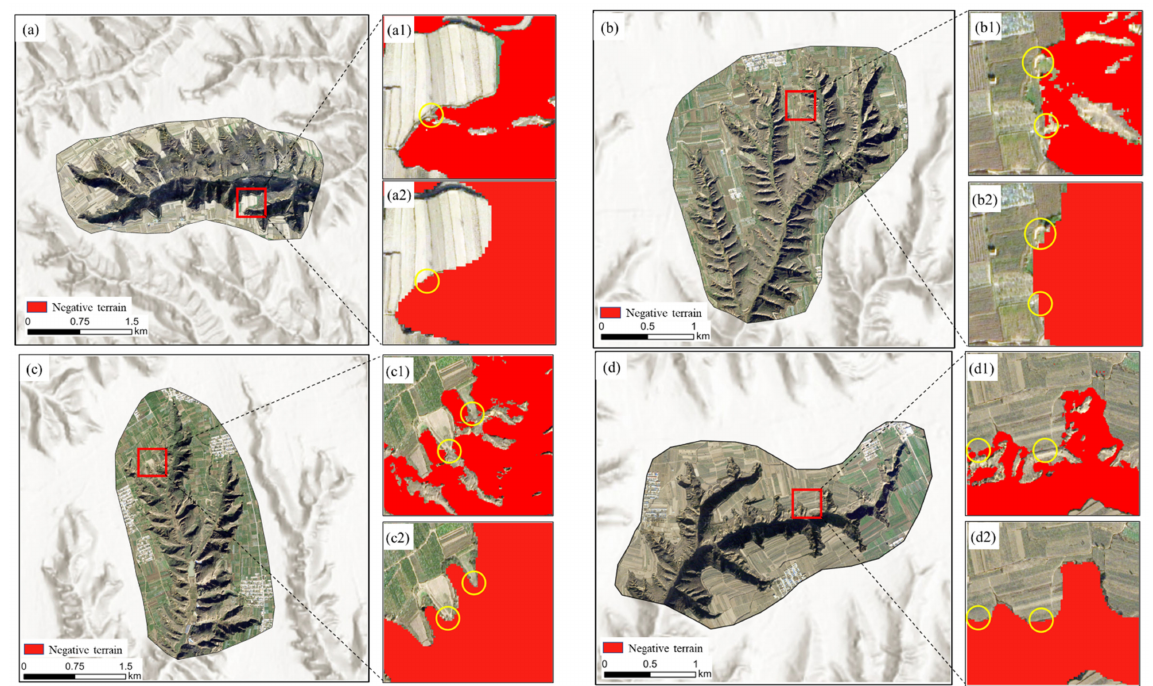
Figure 11. Results of the regional growing algorithm compared to edge detection: ( a – d ) represent 4 sample areas; ( a1 , b1 , c1 , d1 ) represent the results of the edge detection method; ( a2 , b2 , c2 , d2 ) repre- sent the results of the regional growing algorithm.